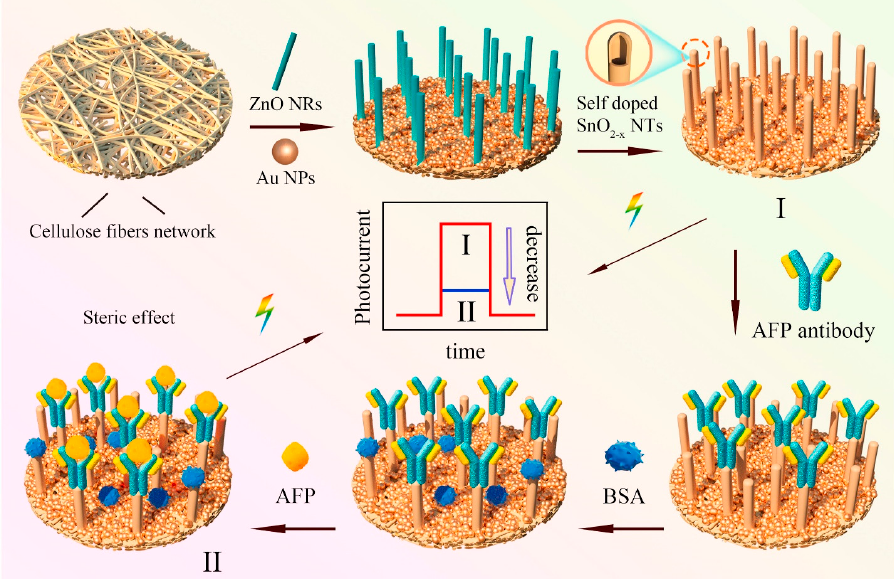
Figure 3. Schematic illustration of the construction of paper-based Sn-doped SnO 2-x sample and assay procedures for the specific detection of cancer biomarker alpha fetoprotein. Reproduced with the permission. [202] Copyright 2021,